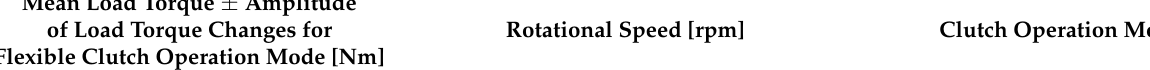
Figure 6. Test stand; designations: 1—driving motor, 2—stiff sleeve clutch, 3, 9, 13, 15—torque meters (respectively: M1, M2, M4, M3), 4, 7—bearing support, 5—relative rearrangement angle sensor for active and passive coupling members, 6—torsionally flexible metal clutch, 8—Polytec RLV-5500 laser vibrometer, 10—gear’s input shaft bearing housing, 11—multistage reduction gear (subject to